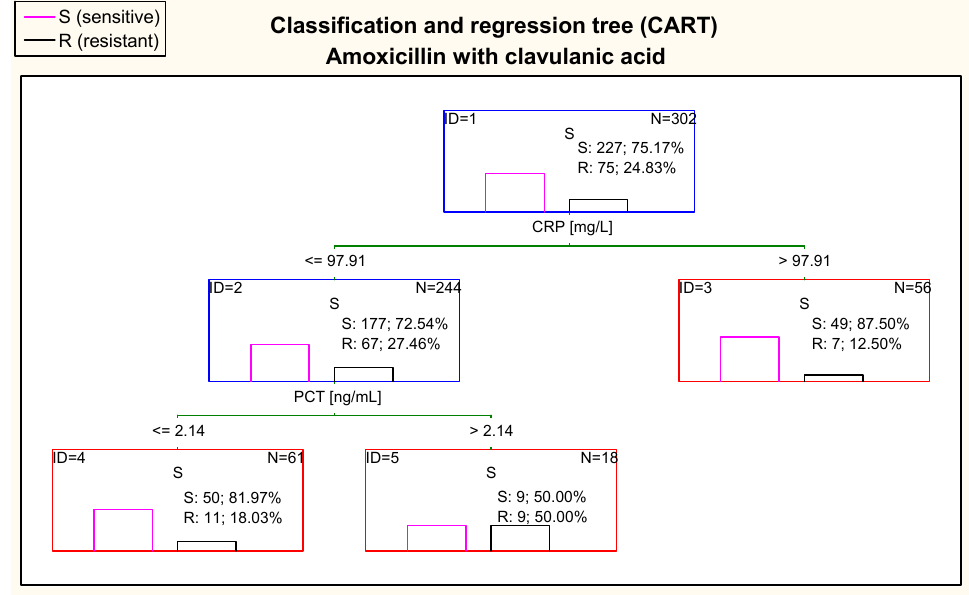
Figure 10. Sensitivity and resistance of bacteria to antibiotics from 2010–2017: ( a ) ampicillin; ( b ) amoxicillin with clavulanic acid; ( c ) gentamicin; ( d ) cefuroxime; ( e ) ceftazidime; ( f ) nitrofurantoin; ( g ) cotrimoxazole. Further, in case of cefuroxime, there were optimal cut–off points of CRP and PCT values in estimating risk of resistance of E. coli . 100% of children with CRP > 0.42 mg/land PCT ≤ 6.92 ng/mL had confirmed sensitivity to cefuroxime in antibiograms (Figure 13).